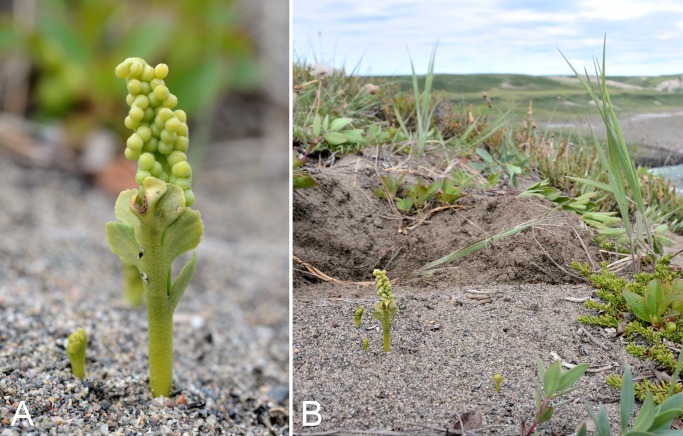
Botrychium minganense.(A) Habit, Saarela et al. 4179a. (B) Habitat, Saarela et al. 4179a. Photographs by R. D. Bull.